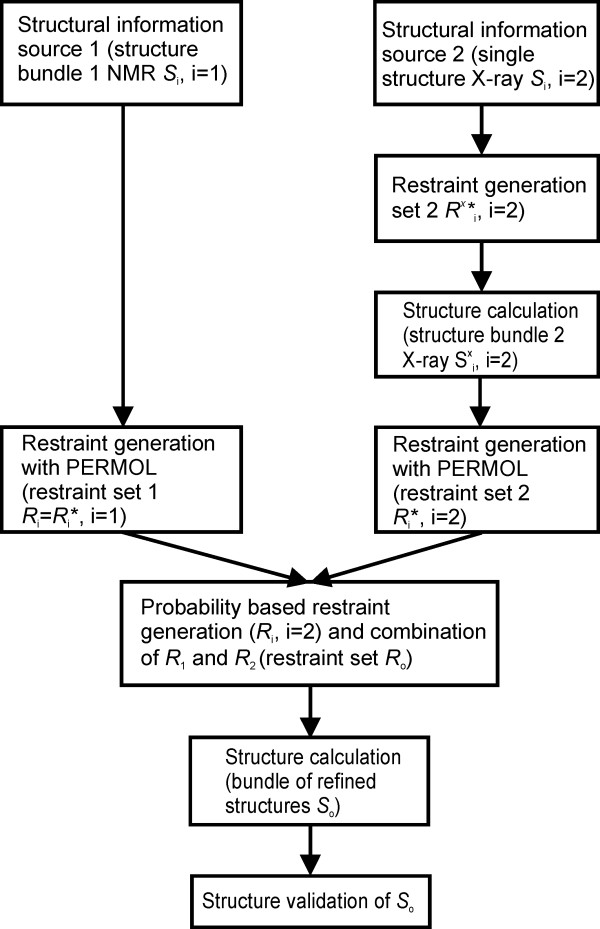
Schematic description of the ISIC algorithm. In the above example two input sources are used, one representing a bundle of NMR structures S1 and one representing a single X-ray structure S2.